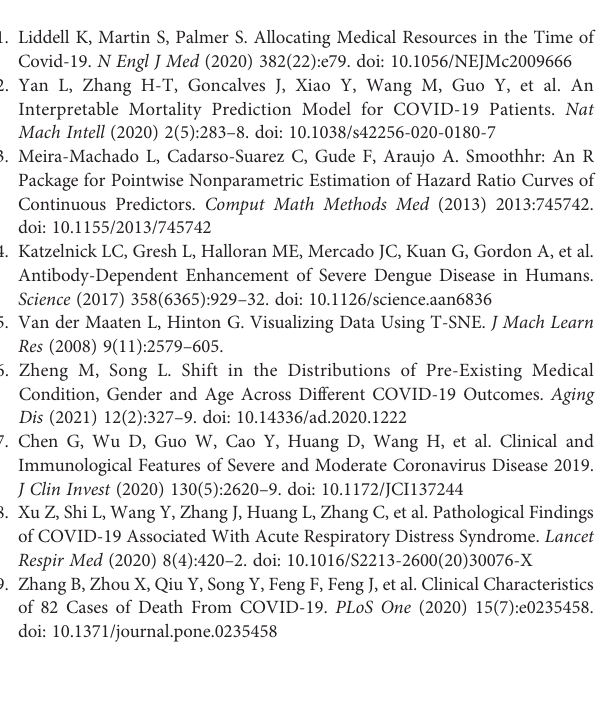
Supplementary Figure 1 | Informative characteristics of laboratory tests in COVID-19 patients. SE, standard error; SV, coef fi cient of variation. Supplementary Figure 2 | Diagram of prognostic analysis of continuous hemogram values. Based on Cox proportional hazard regression, the point wise hazard ratio (HR) was calculated for each of the continuous hemogram values, taking the median hemogram value as the reference. The associations between hemogram parameters and survival were assessed by both univariate and multivariate Cox regression. Next, Kaplan-Meier curves were plotted to show the overall survival of COVID-19 patients according to hemogram values. Supplementary Figure 3 | Continuous log-HR curves (solid line) with 95% CIs (shading) show the association of lactate dehydrogenase (LDH), basophil (%), albumin with OS in COVID-19 patients. The age- and sex-adjusted HRs were fi tted based on Cox proportional hazards regression. The x-axis shows the normalized hemogram values by Min-Max Scaler (MMS). Supplementary Figure 4 | The Kaplan-Meier curves show OS of COVID-19 patients according to neutrophils (%) in cohort 1. Log-rank p values and HRs (95% CIs) show the comparison between patients with neutrophils (%) ≤ 72.50 and > 72.50. The bottom panel shows the number of patients at risk every fi ve